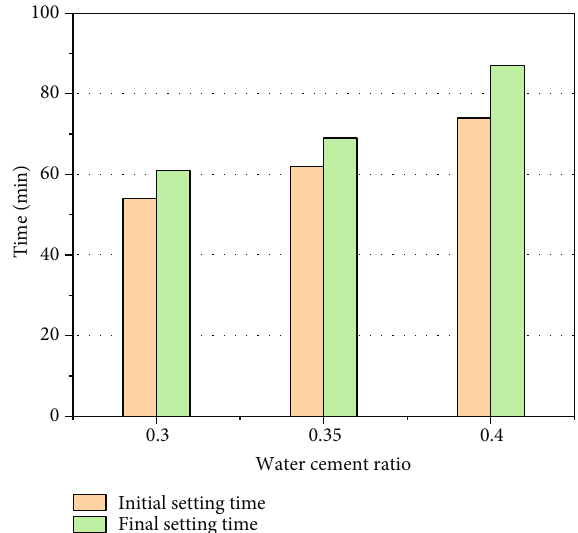
Figure 18: In fl uence of water-cement ratio on setting time.